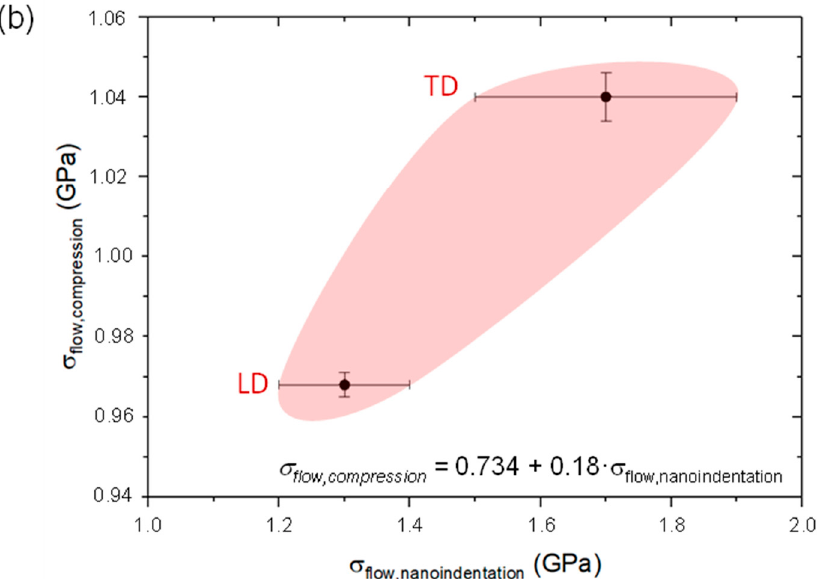
Figure 13. Relationship between flow stress determined under different stress fields and also at different length scales. ( a ) Flow stress under compression vs. under the tensile test; both tests were performed at the macroscopic length scale and ( b ) flow stress under compression (macroscopic length scale) vs. the one determined at the micrometric length scale using the composite indentation hardness and Tabor’s equation.